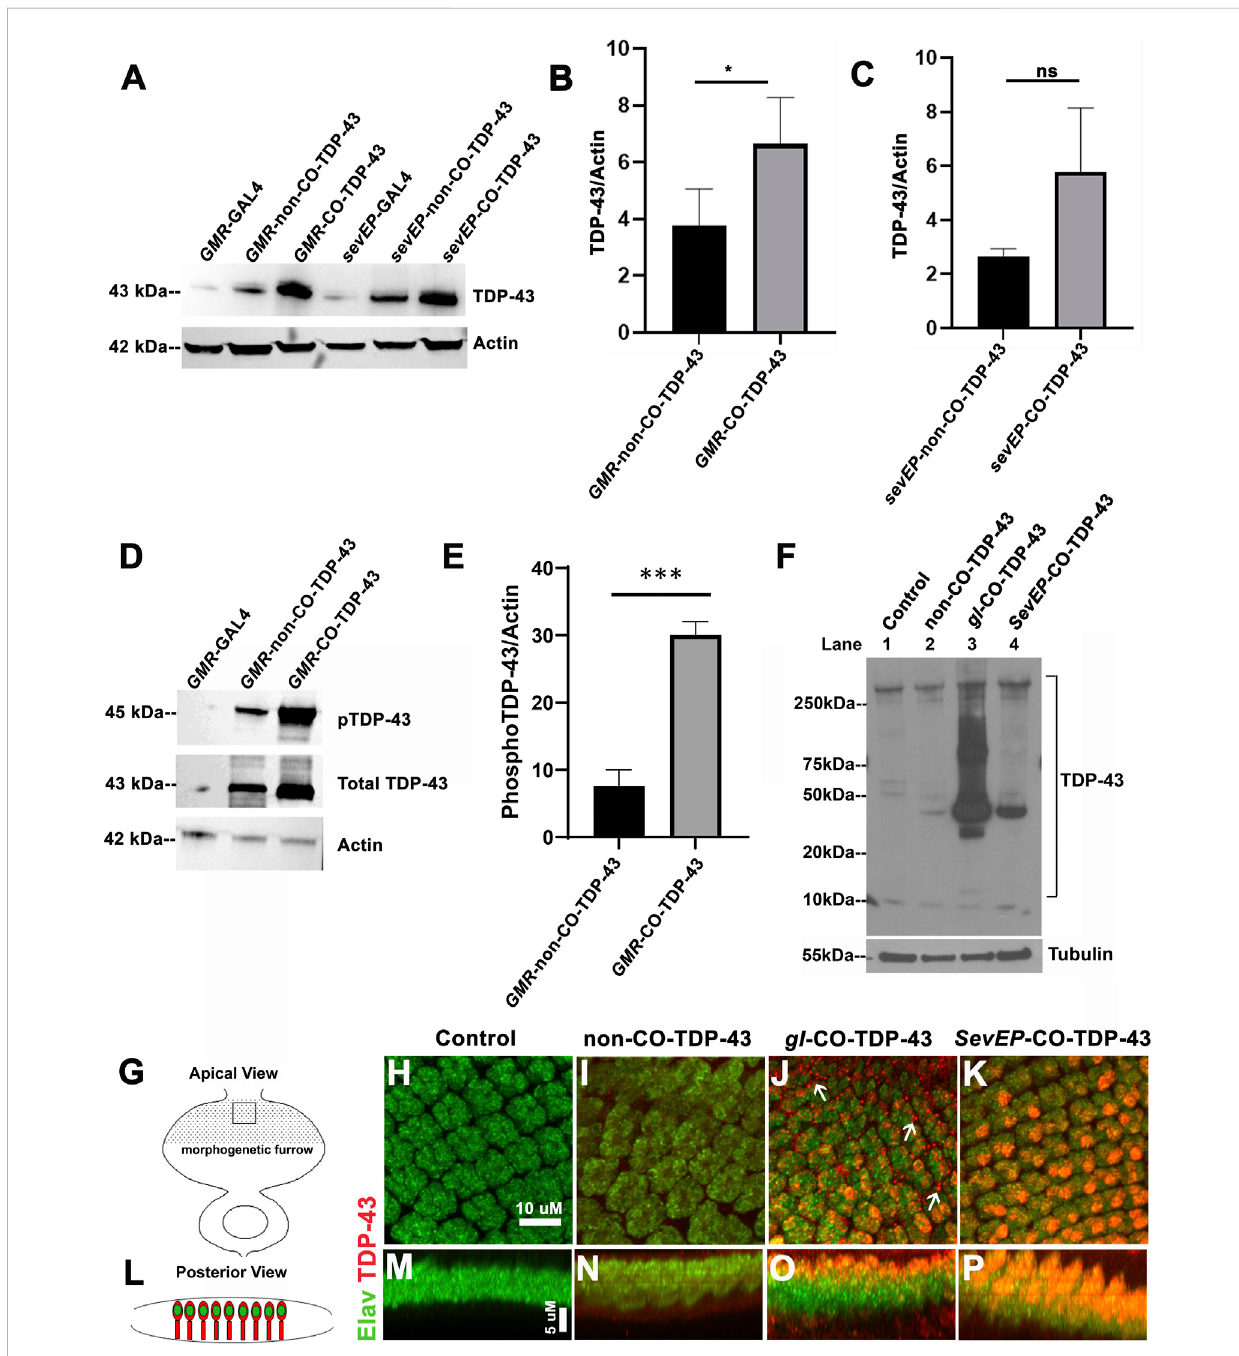
FIGURE 3 Codon optimized TDP-43 transgenic fl y expresses higher total and phosphor-TDP43 protein levels, with robust mislocalization to the cytoplasm and aggregate formation in larval eye discs. (A) Western blot comparing the levels of total TDP-43 protein in the Controls vs CO-TDP-43 and non-CO- TDP-43 transgenics driven by the GMR -GAL4 and SevEP -GAL4 driver. These blots are probed with total TDP-43 antibody with Actin as the loading control. (B, C) Bar graphs displaying relative levels of TDP-43 derived by densitometric analysis from three separate blots. The level of expression is 2-fold higher in CO-TDP-43 transgenics compared to non-CO-TDP-43 lines in control of the GMR -GAL4 driver. Paired t -test between the transgenics shows a statistical signi fi cance * p < 0.02. There is also an increase in the case of CO-TDP-43 transgenics with SevEP -GAL4 compared to non-CO-TDP- 43 fl ies, but this is not signi fi cant. (D) An enhanced level of phosphorylation at the Ser409/410 epitopes is found in the GMR -GAL4 driven CO-TDP- 43 transgenics compared to non-CO-TDP-43 lines normalized to Actin levels. (E) Bar graphs displaying relative levels of phospho-TDP- 43 phosphorylation derived by densitometric analysis. The level of expression is 3-fold higher in CO-TDP-43 transgenics compared to non-CO-TDP- 43 lines using GMR-GAL4 driver. Paired t -test between the transgenics shows a statistical signi fi cance *** p < 0.0005. (F) CO-TDP-43 ( gl -CO-TDP-43, lane 3) exhibits higher molecular weight species of TDP-43 as well as the known 35kD truncated c-terminal fragment compared to human wild-type non-CO-TDP-43 (lane 2) or the SevEP -GAL4 driven CO-TDP-43 (lane 4). Lane 1 is wild-type control. β -tubulin is presented as a loading control. (G, L) Schematic of the third instar larval imaginal eye-antennal disc from an apical and posterior view, respectively. The area represented with the rectangular box in (G) is the area imaged. (H – P) Confocal images of the third instar imaginal eye discs stained with neuronal marker Elav (green) and TDP-43